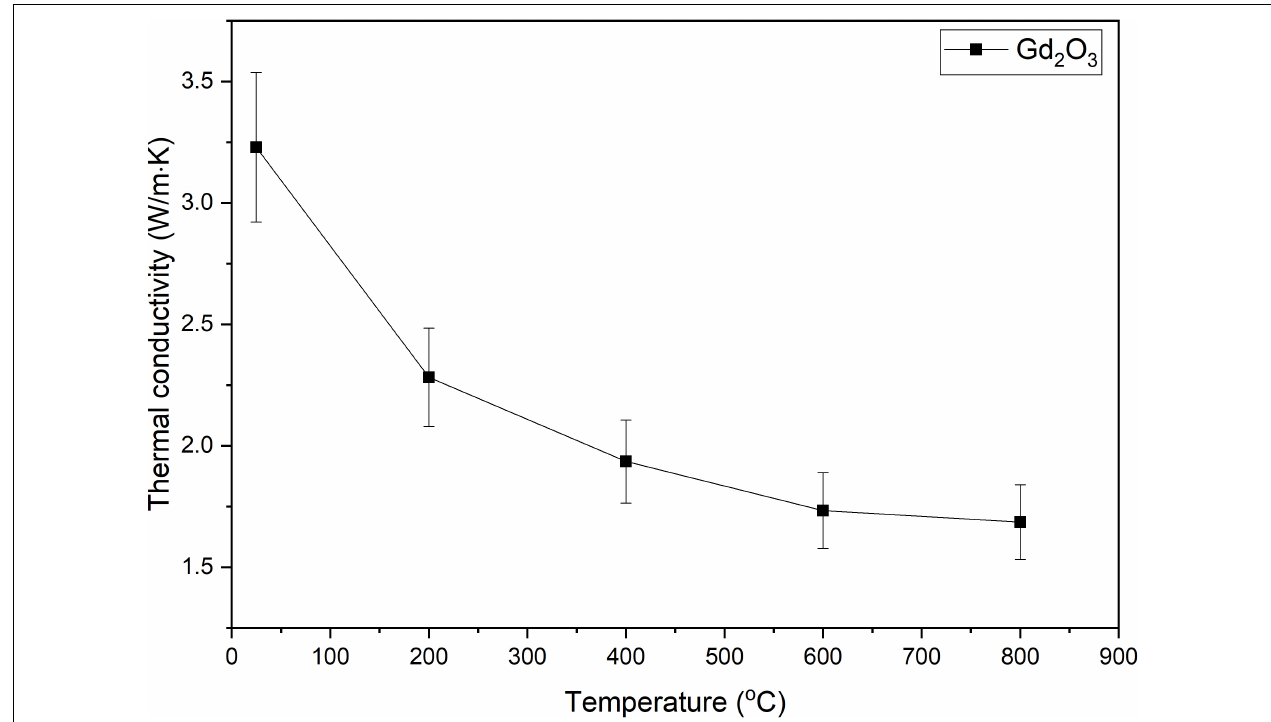
FIGURE 1 | Thermal conductivity of fully dense Gd 2 O 3 with increases in sintering temperature from 25 ◦ C to 800 ◦ C.